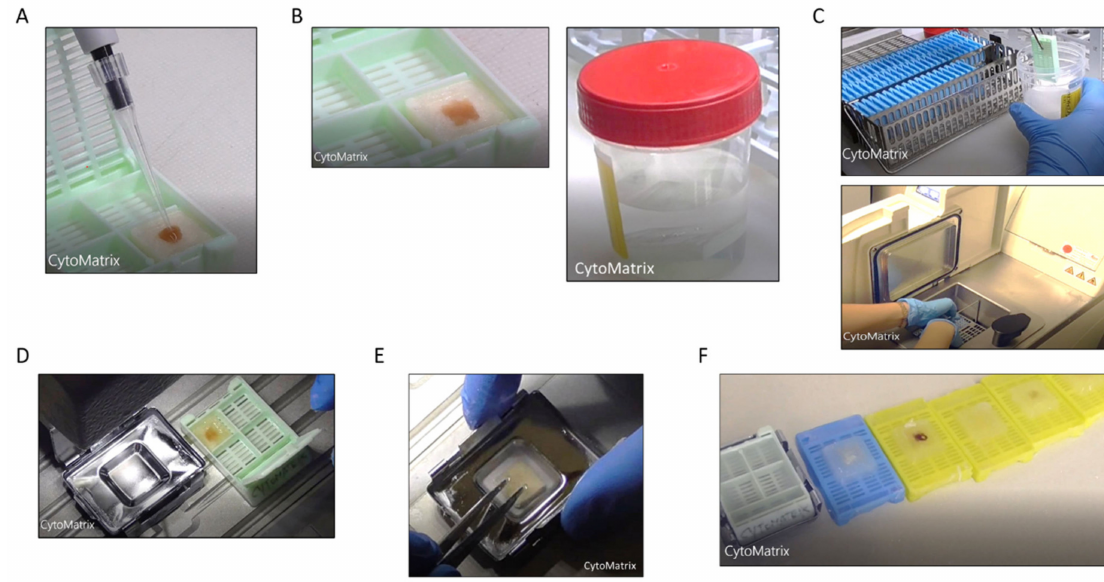
Figure 1. CytoMatrix preparation for urine specimens ( A ) Load the cellular suspension into the center of CytoMatrix. ( B ) Absorb and fix in buffered formalin. ( C ) Process the CytoMatrix-sample in automatic tissue processor. ( D ) Add Molten paraffin in tray. ( E ) Press the CytoMatrix flat to the bottom. ( F ) Cool and extract the FFPE-CytoMatrix